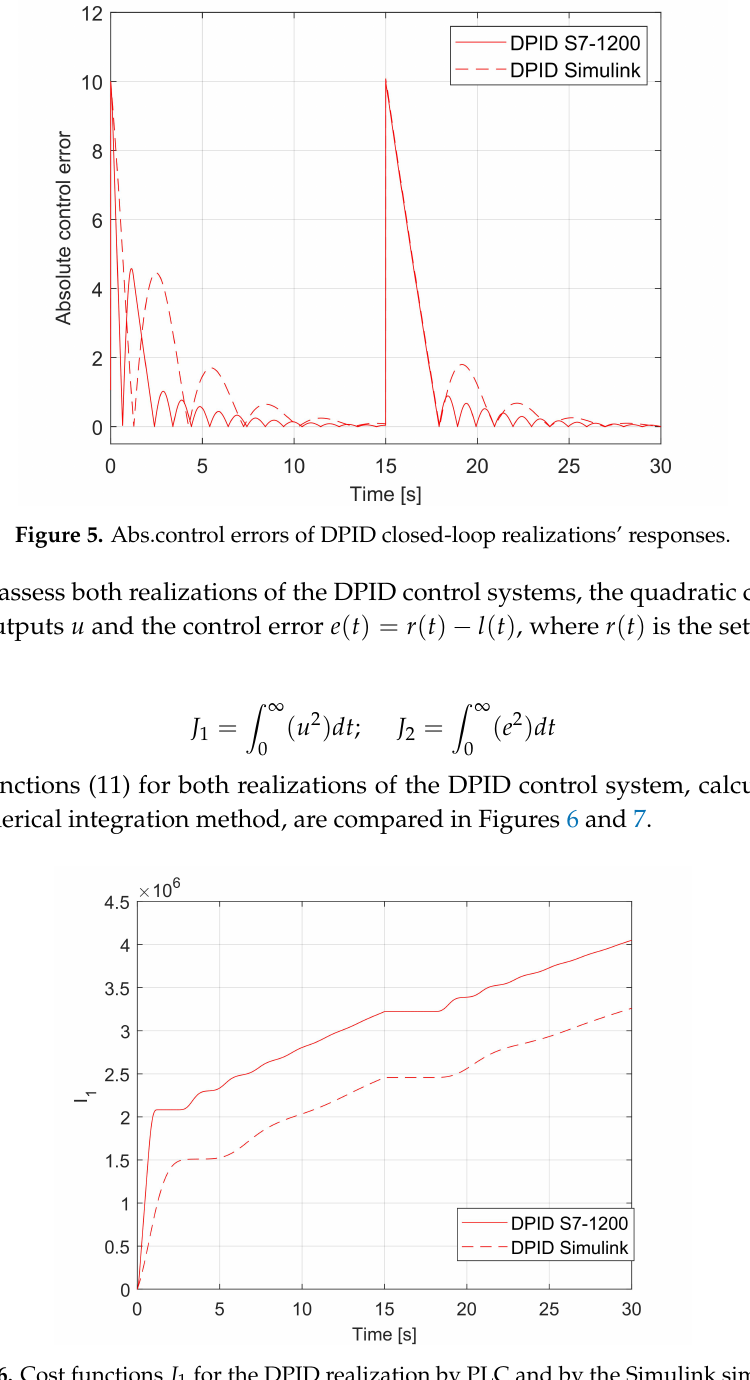
Figure 6. Cost functions J 1 for the DPID realization by PLC and by the Simulink